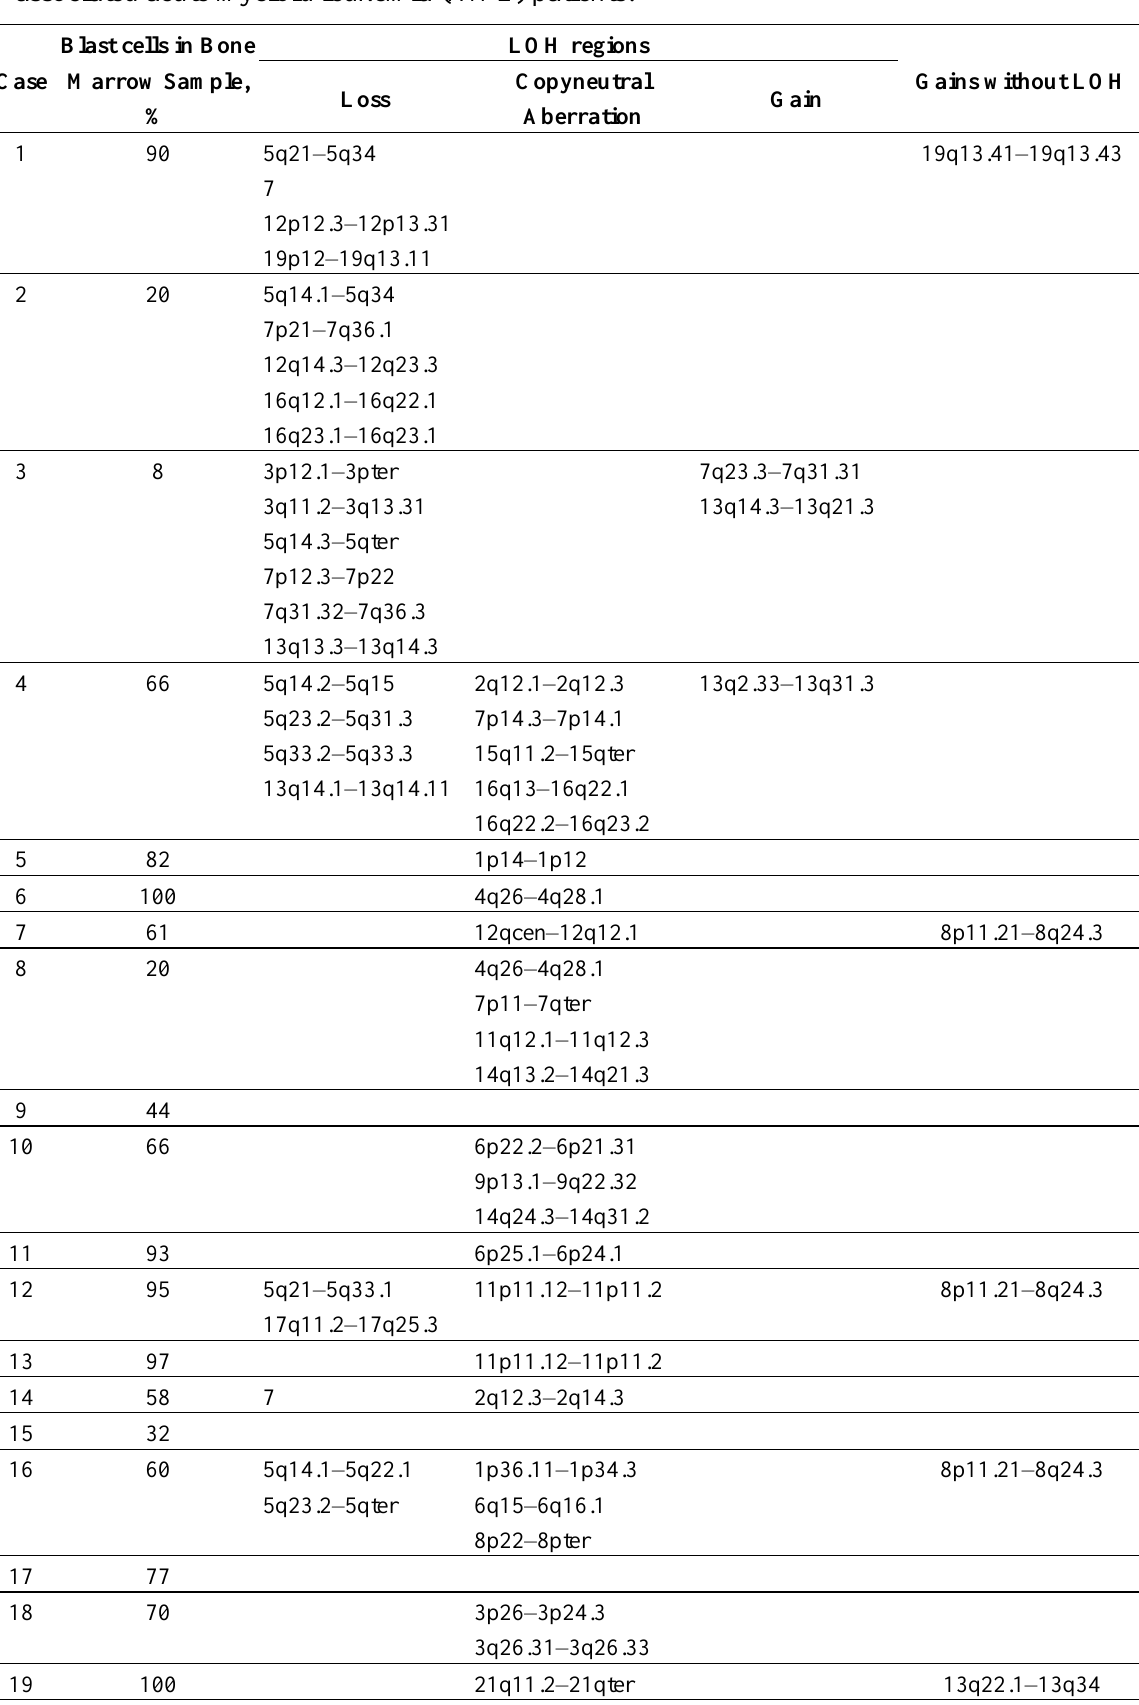
Table 1. Sample and chromosomal loss-of-heterozygosity (LOH) information of radiation- 1 associated acute myeloid leukemia (AML)